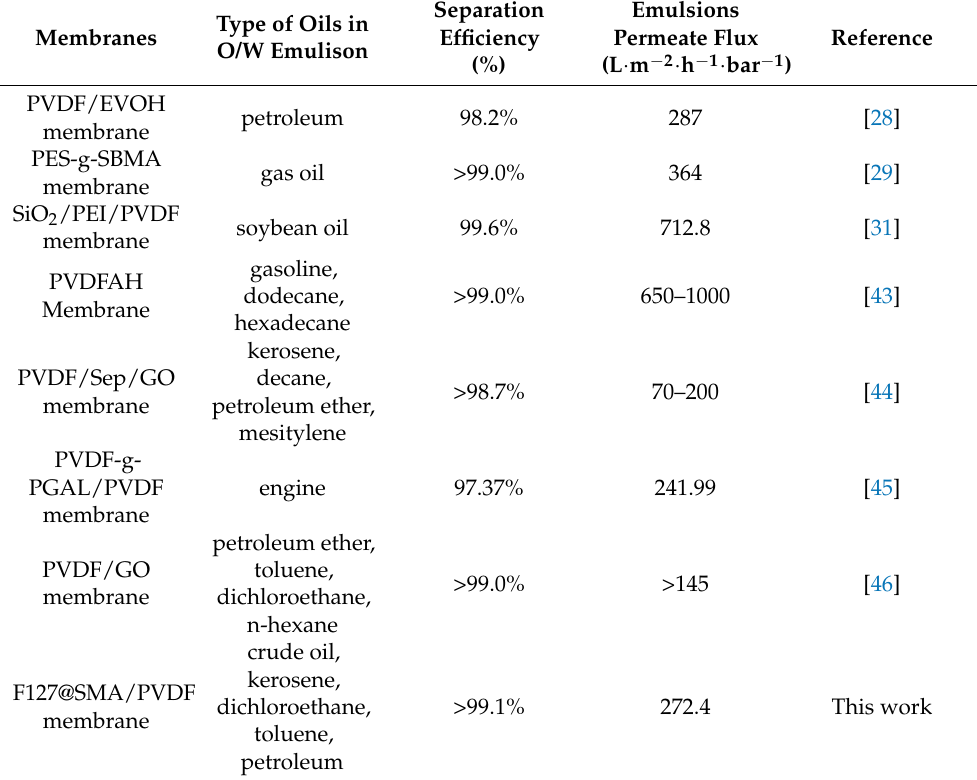
Table 4. Comparison of various membranes used to separate oil-in-water emulsions.